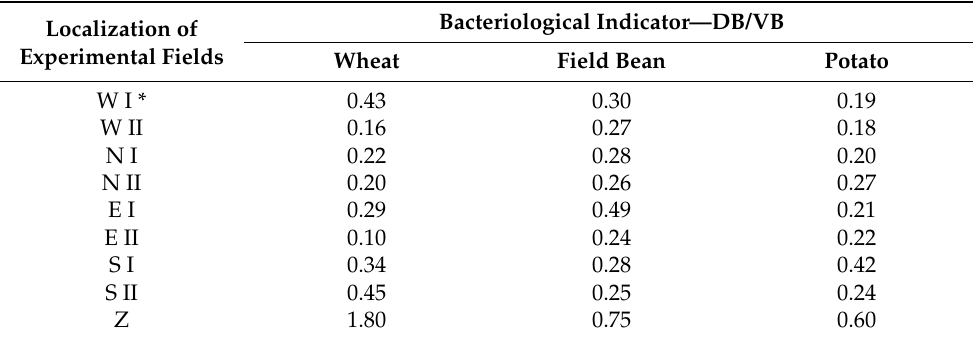
Table 4. Bacteriological indicator of soil quality near the municipal landfill site (the ratio of the number of sporulating bacteria to the number of vegetative forms—own